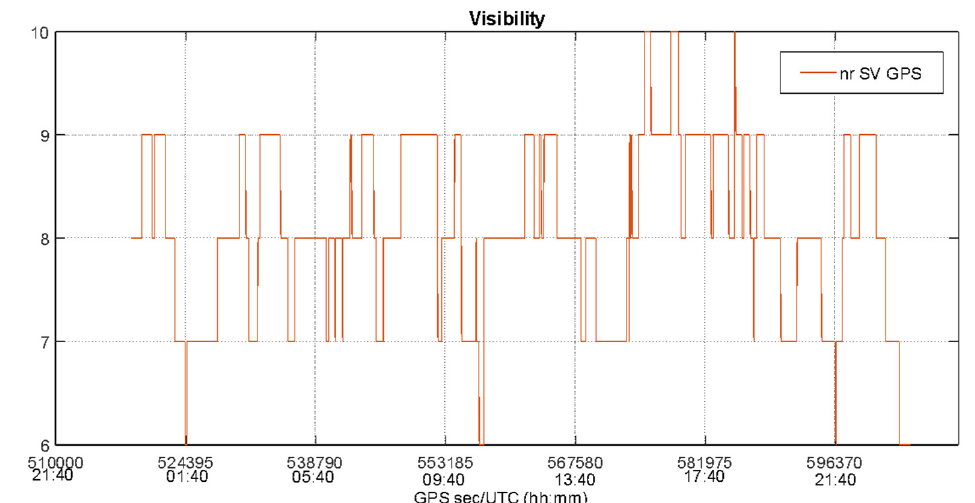
Figure 3. Number of visible GPS satellites during the static test.